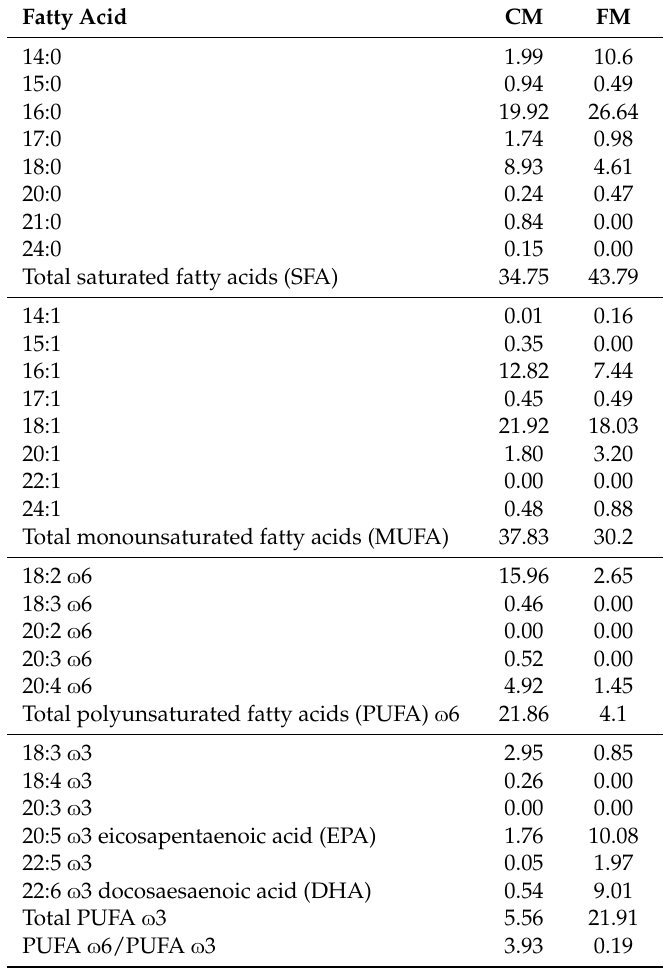
Table 2. Fatty acid profile (% of total fatty acids) of CM and FM used in the trial. Fatty